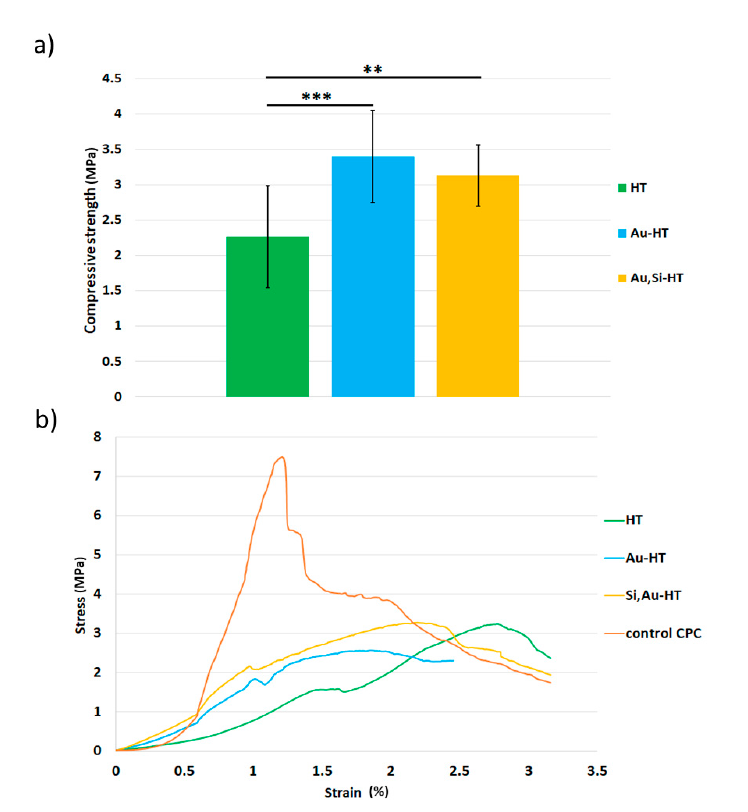
Figure 2. The compressive strength ( a ) and compressive stress–strain curves ( b ) of biomicroconcretes 7 days after setting and hardening. Control CPC- α TCP-based bone cements without granules. Statistically significant differences indicated by ** p ≤ 0.01 and *** p ≤ 0.001.